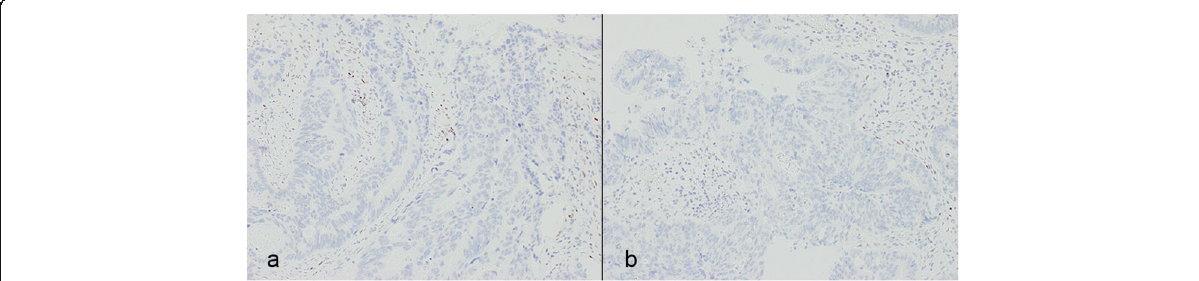
Fig. 8 For immunohistochemical staining, both adenocarcinomas of the transverse colon ( a ) and rectum ( b ) were negative p53 immunohistochemical staining. This was a supportive finding that suggested both tumors were of the same